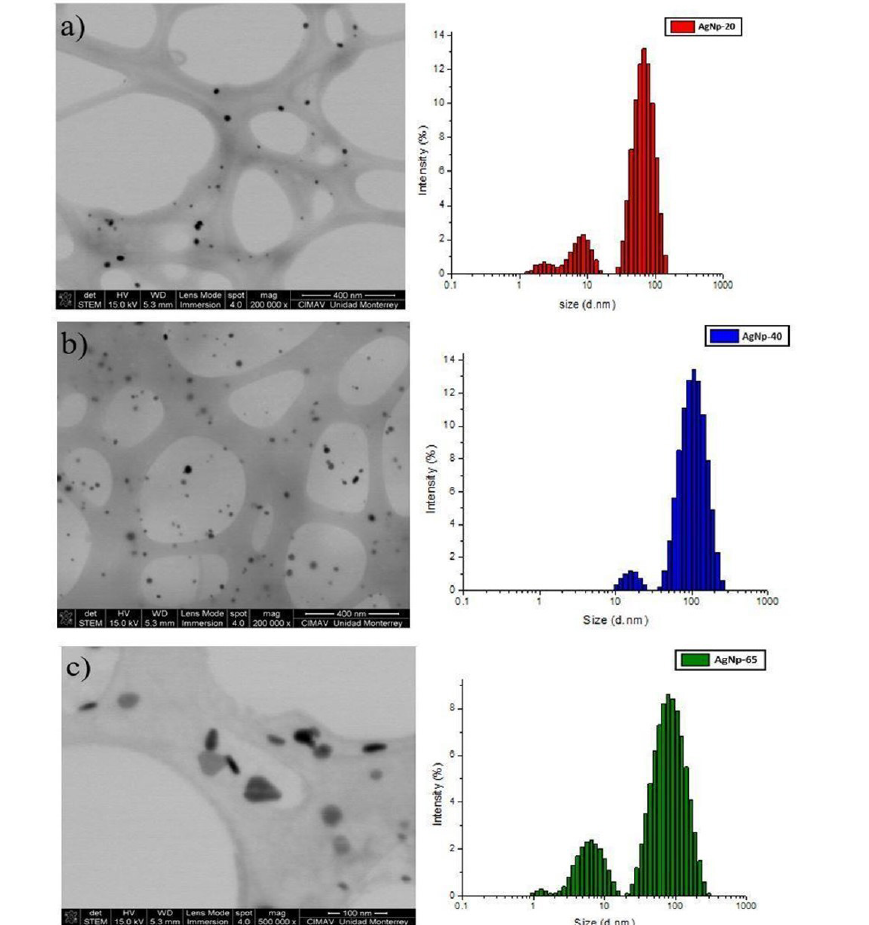
Figure 3. STEM/SEM micrographs (left) and particle size distribution (right) of AgNPs with the maxima of the plasmon absorption band at a) 437 nm, b) 515 nm and c) 632 nm.